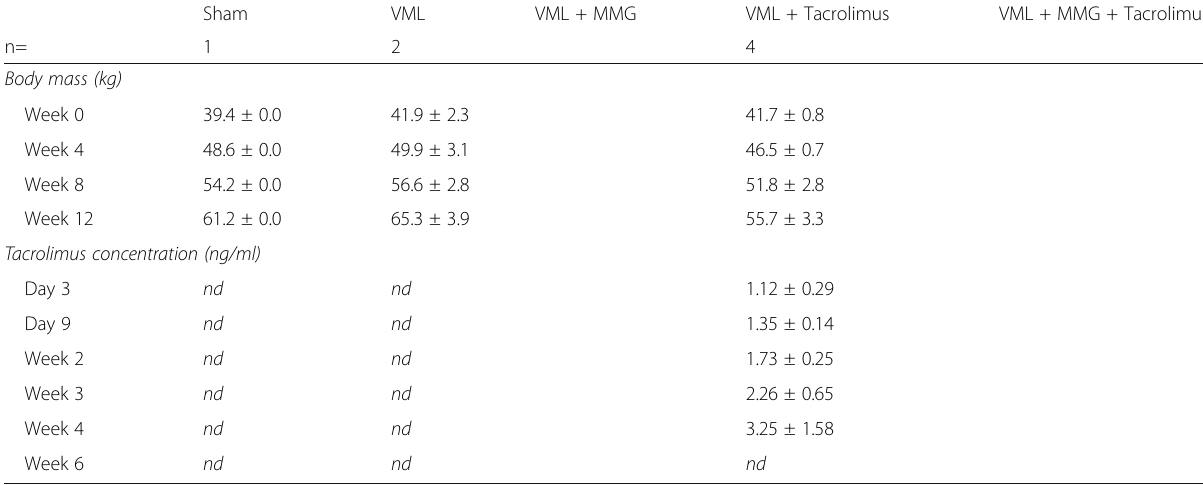
Table 1 Characteristics across study